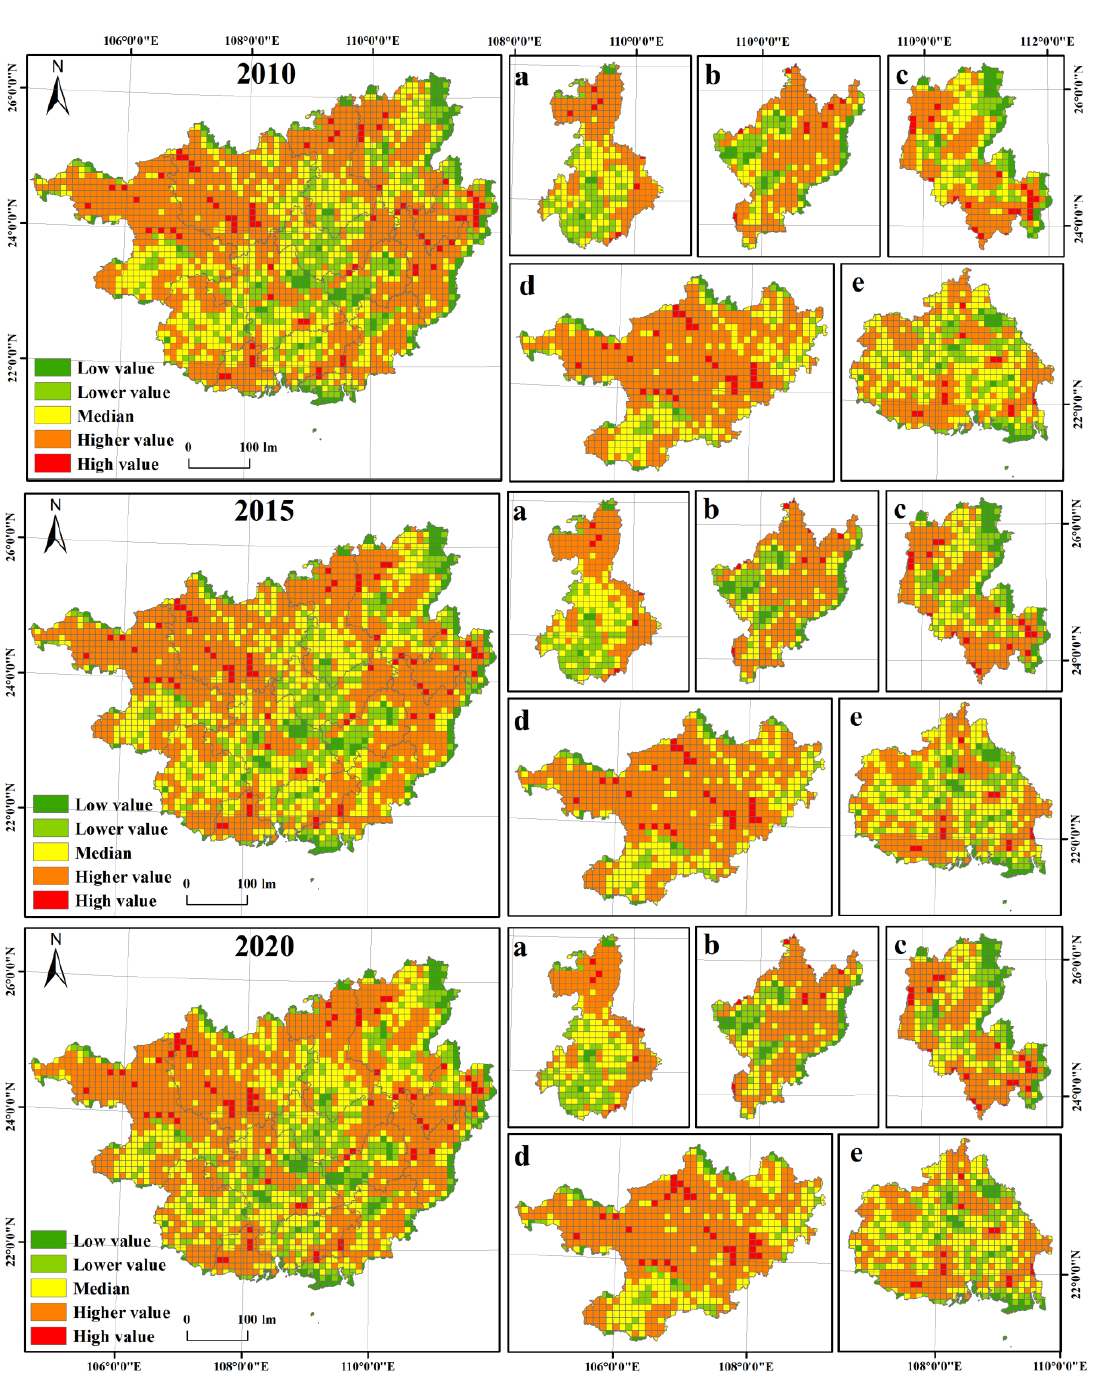
Figure 4. Ecological value grid distribution map of Guangxi and each consolidation area. (Note: ( a ) is the middle karst basin area of Guangxi, ( b ) is the southeast plain area of Guangxi, ( c ) is the northeast hilly mountain area of Guangxi, ( d ) is the northwest mountain area of Guangxi, ( e ) is the coastal hilly plain